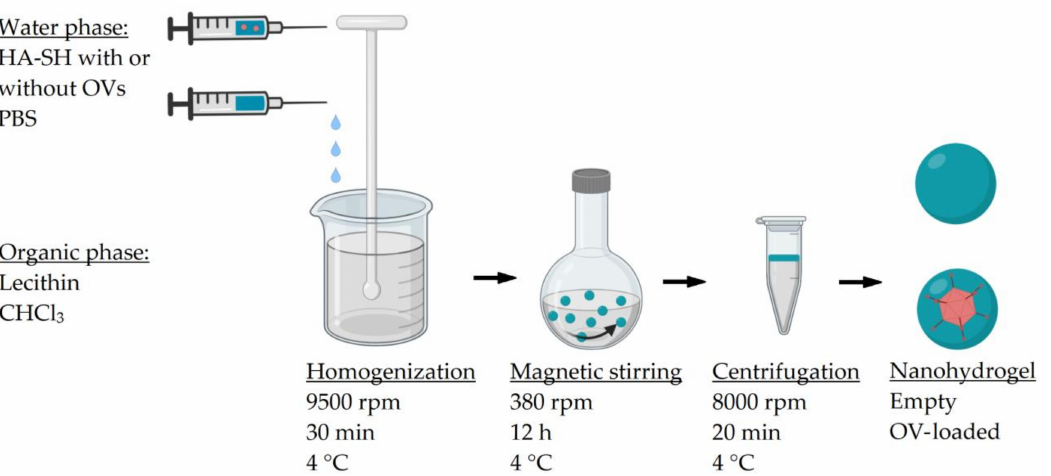
Figure 2. Schematic diagram of empty nanohydrogel and OV-loaded nanohydrogel formulation by water in oil (W/O) nanoemulsion optimized